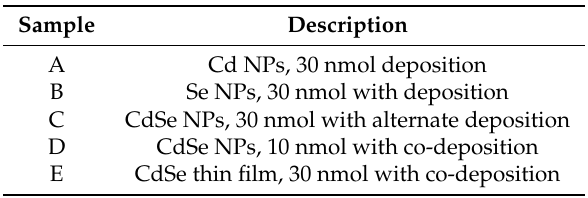
Table 1. Scheme of the samples synthesized in this